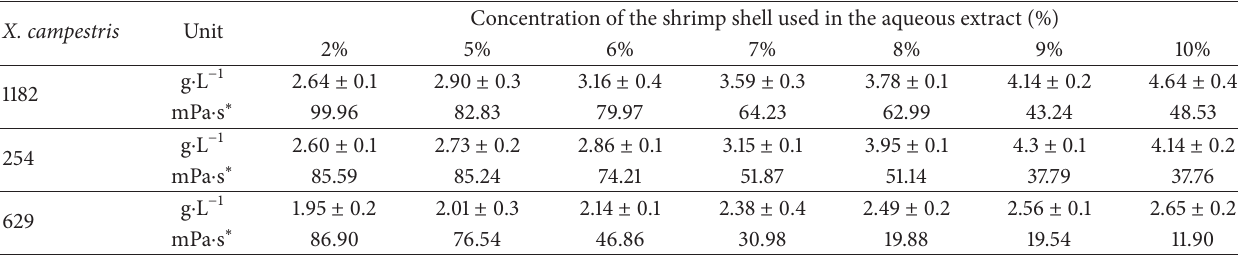
Table 5: Productivity in xanthan gum (g ⋅ L −1 ) and viscosity (mPa ⋅ s) by strains of Xanthomonas campestris with different concentrations of aqueous shrimp shell